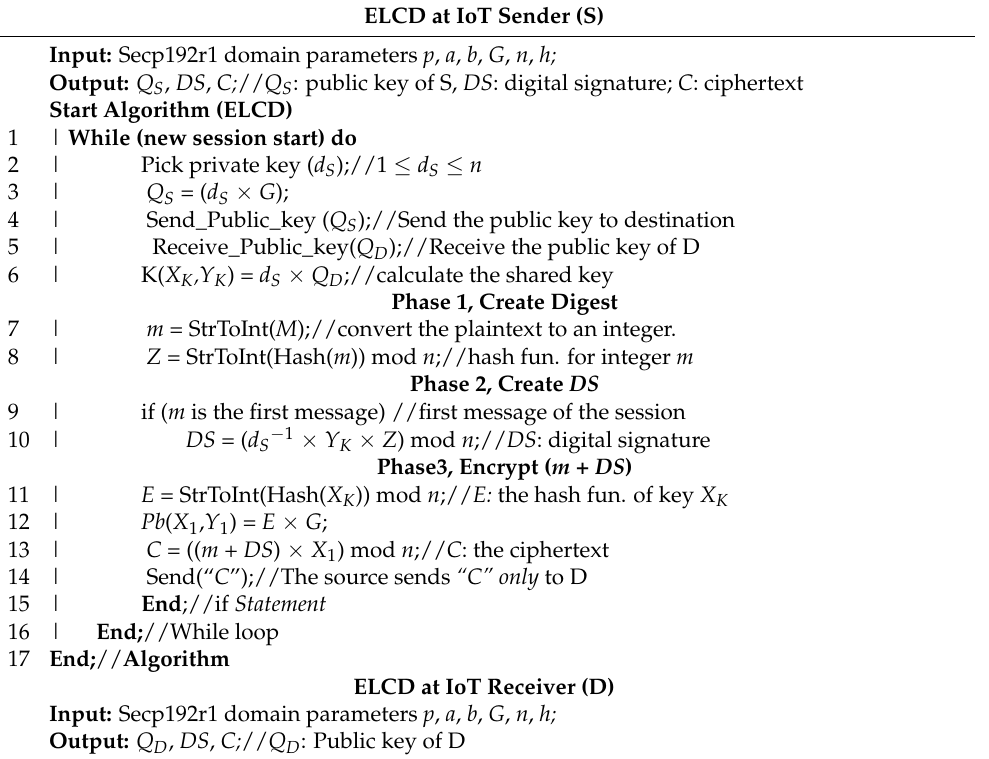
Table 3. The ELCD